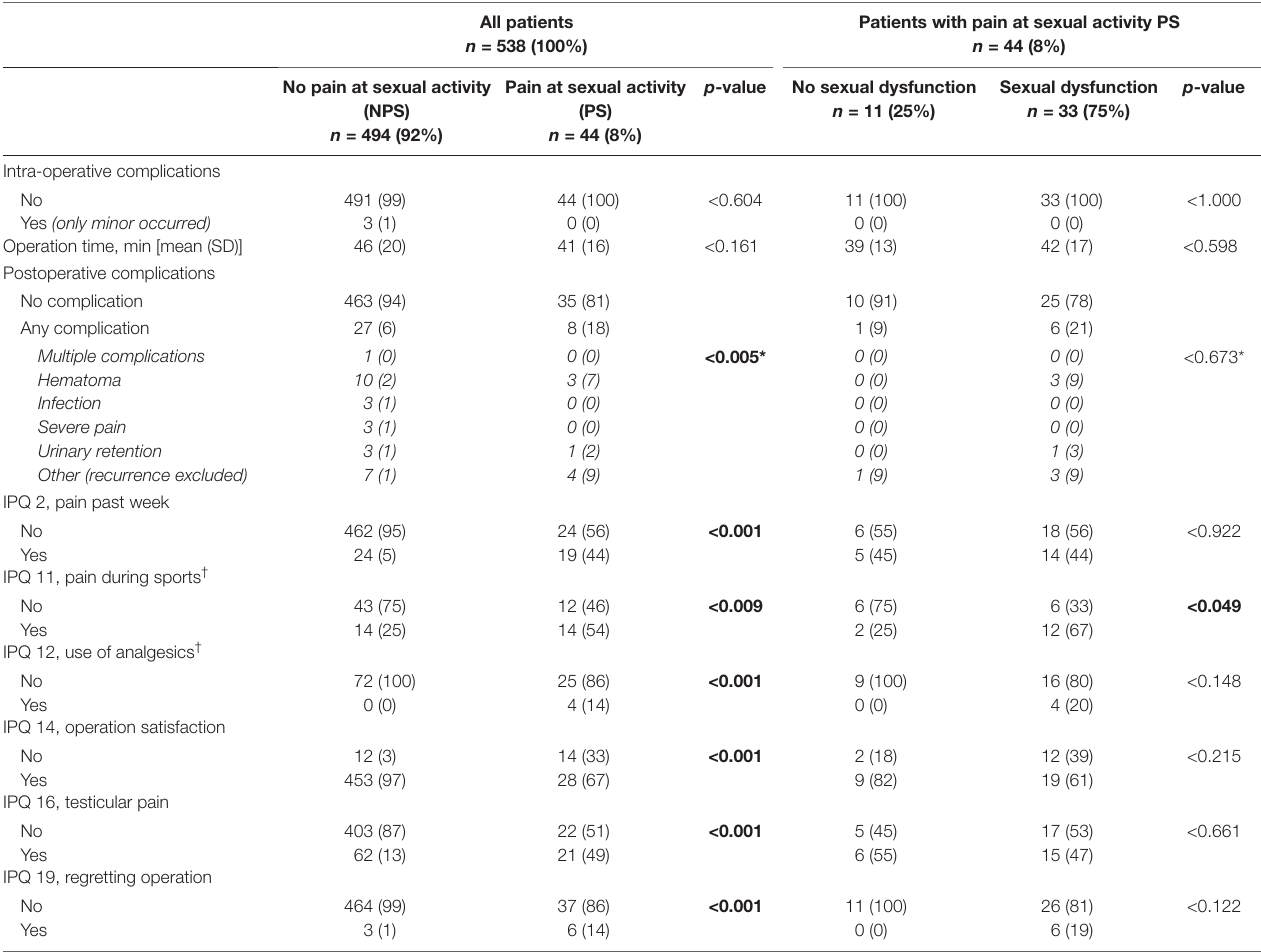
Table 2 | Operative and postoperative data.